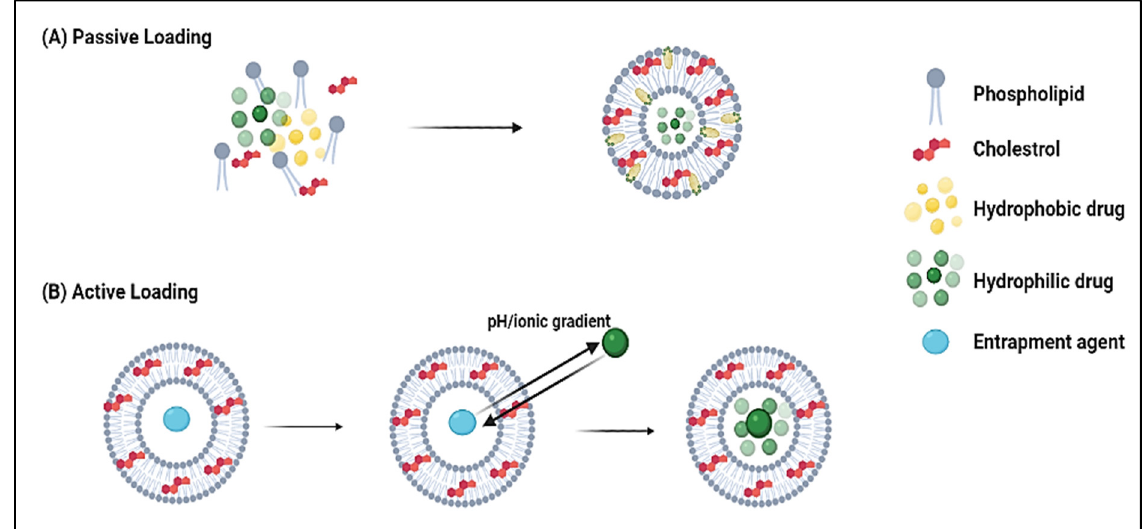
Figure 5. Two approaches for DOX loading into liposomes: passive and active. ( A ) before “pasive” and ( B ) before On the other hand, the size stability and release profiles were determined over an extended period. The filtered and sonicated/centrifuged negatively-charged liposomes were stable during the entire storage period and maintained average diameters of 270 and 120 nm, respectively. However, the sonicated/centrifuged positively-charged liposomes were not stable and had a size of 120 nm with a standard deviation of 40 nm over 2 weeks of storage. The negative filtered liposomes released only 10% of DOX during 75 days, whereas 40% was released over 20 days from the negative sonicated/centrifuged lipo- somes. For the release from positive sonicated/centrifuged liposomes, the baseline was set after 12 days, and the cumulative release was ~30% after 48 days [47].